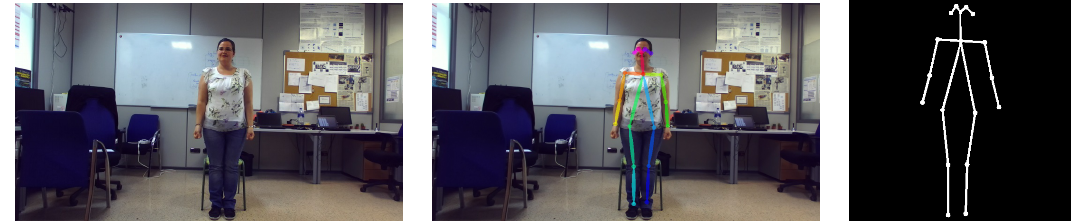
Figure 3. A sample of the 3D human skeleton extraction by using Openpose [29,30]. The left image corresponds to the captured frame; the middle one shows the estimated skeleton on the original image; and, the last one represents the resulting 3D human skeleton.